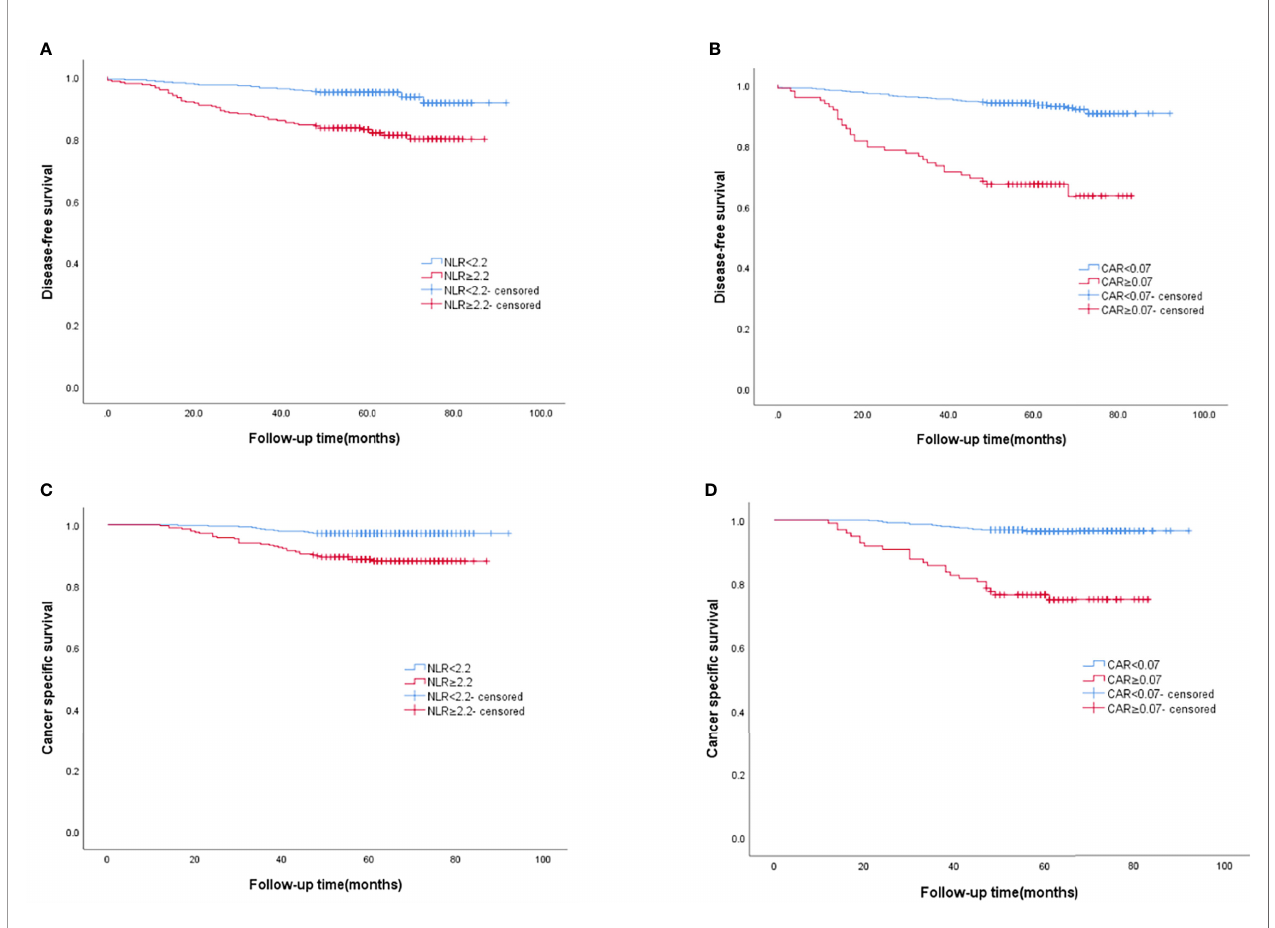
FIGURE 3 | The Kaplan – Meier curves of DFS according to (A) NLR, (B) CAR, and the Kaplan – Meier curves of CSS according to (C) NLR, (D)